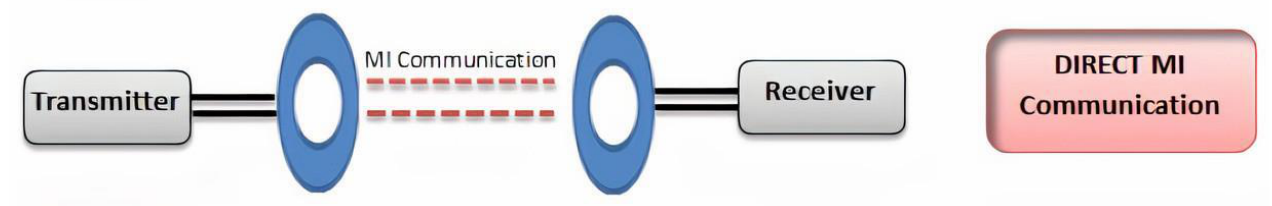
Figure 3. Structure of direct MI communication.